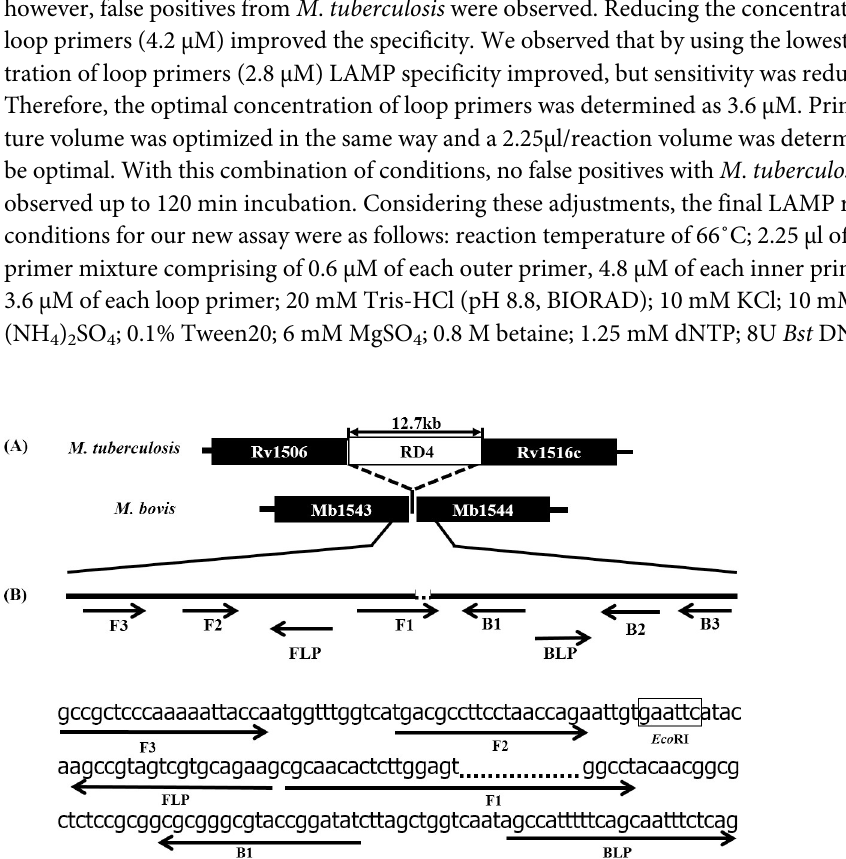
Fig 1. LAMP primers for specific detection of M . bovis targeting the RD4 flanking region. (A) Position of the RD4 deletion on M . bovis genome, shown with reference to M . tuberculosis . The RD4 locus is present in M . tuberculosis but deleted from M . bovis . (B) The target sequence, individual primers, annealing positions and their directions of the set of primers with RD4 deletion at 3-prime region of F1 primer are shown. Restriction enzyme Eco RI target sequence is indicated in a box between F2 and